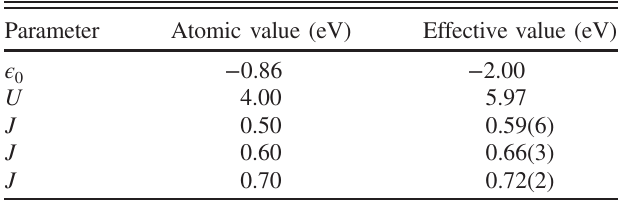
TABLE II. Atomic parameters and their effective values ob- tained from the spectral functions shown in Figs. 5 and 8. For J , the values themselves were obtained from the energy difference of the highest peak to the lowest peak, whereas the uncertainty is 2 J and ω − J estimated from ω M þ M